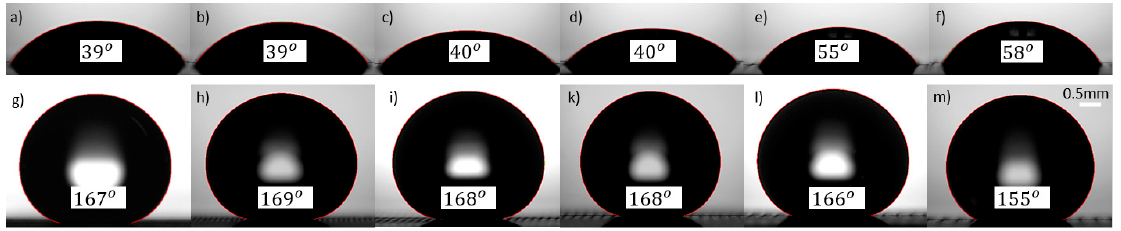
Figure 5. Images of water droplet apparent contact angle: ( a – f ) initial stages, ( g – m ) after heat treatment for line-patterned samples with a step size of 50 µ m ( a , g ), 100 µ m ( b , h ), 150 µ m ( c , i ), 200 µ m ( d , k ), 250 µ m ( e , l ), and 300 µ m ( f , m ) at 3 W with 0.5 mm scale bar for all images.